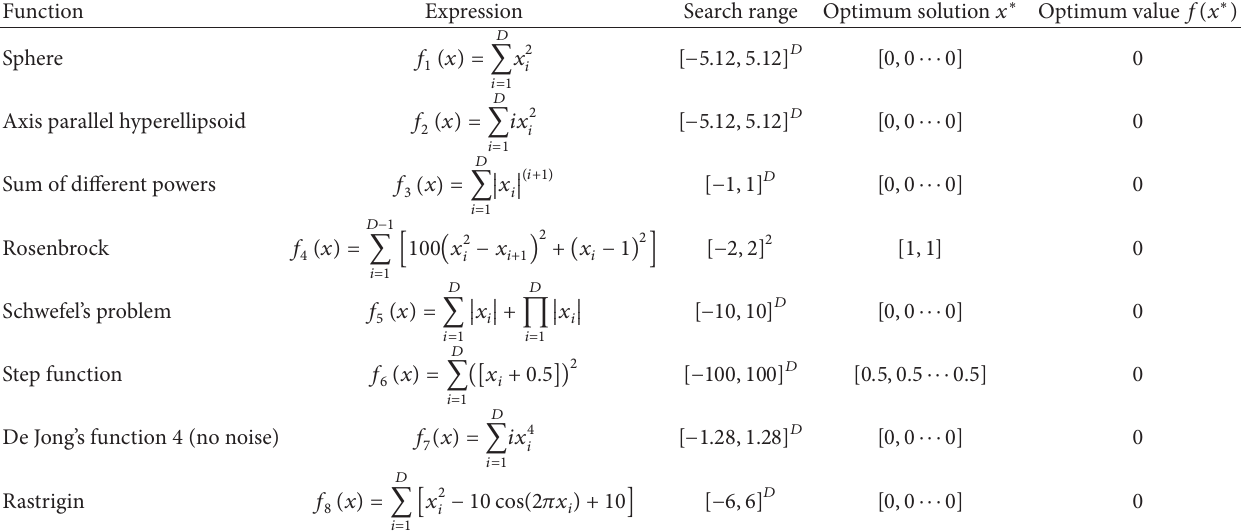
Table 1: Benchmark functions and parameter